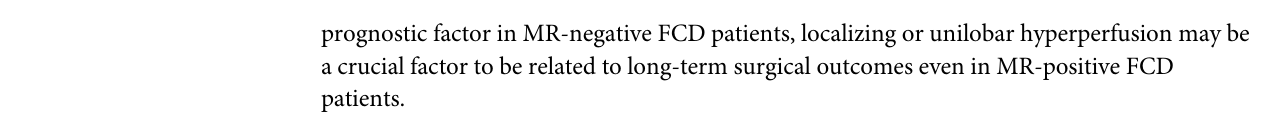
PLOS ONE | https://doi.org/10.1371/journal.pone.0249929 April 14,